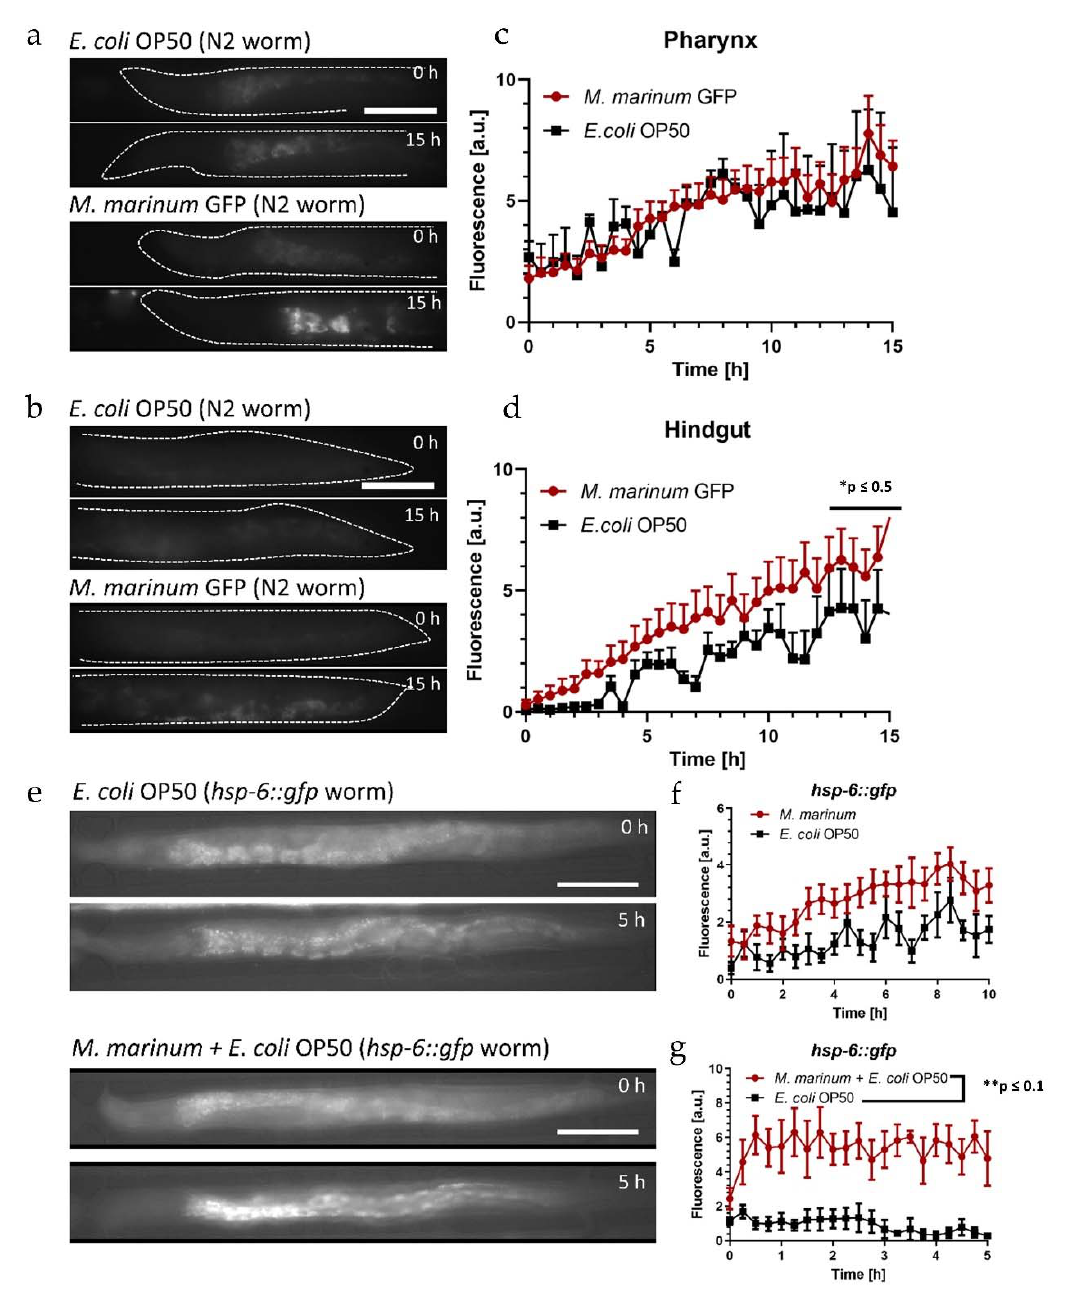
Figure 7. Analysis of bacterial accumulation and UPR mt response in C. elegans nematodes induced by pathogenic M. marinum bacteria. ( a , b ) Fluorescence images (50 × ) of pharynx ( a ) and hindgut ( b ) of an immobilized YA N2 C. elegans , fed OP50 E. coli bacteria or GFP expressing M. marinum , respectively. Worm contours are indicated by dashed lines. Accumulation of M. marinum in the grinder and in the hindgut can be identified after 15 h. ( c , d ) Time evolution of the bacterial load in the pharynx ( c ) and in the hindgut ( d ). Average fluorescent signals were normalized with respect to the E. coli OP50 value measured in the pharynx for each time point (* p ≤ 0.5, n = 10). ( e ) Fluorescence images of immobilized YA hsp-6::gfp mutants fed E. coli OP50 only (top images) and a mixture of M. marinum and E. coli OP50 (bottom images). The immobilized worms are oriented with head to the left. Strong fluorescence due to hsp-6::gfp expression in the worm fed M. marinum is visible in the anterior region of the intestine adjacent to the pharynx. ( f ) Average fluorescence signal related to hsp-6::gfp expression for nematodes fed M. marinum only and E. coli OP50 only, respectively ( n = 5). ( g ) Fluorescence signal related to hsp-6::gfp expression for nematodes fed a mixture of M. marinum / E. coli OP50 and with E. coli OP50 only, respectively. E. coli OP50 were added to M. marinum to verify that the increase in hsp-6::gfp expression is not caused by worm starvation (** p ≤ 0.1, n = 5). Error bars correspond to mean ± SEM. Scale bars = 100 µ